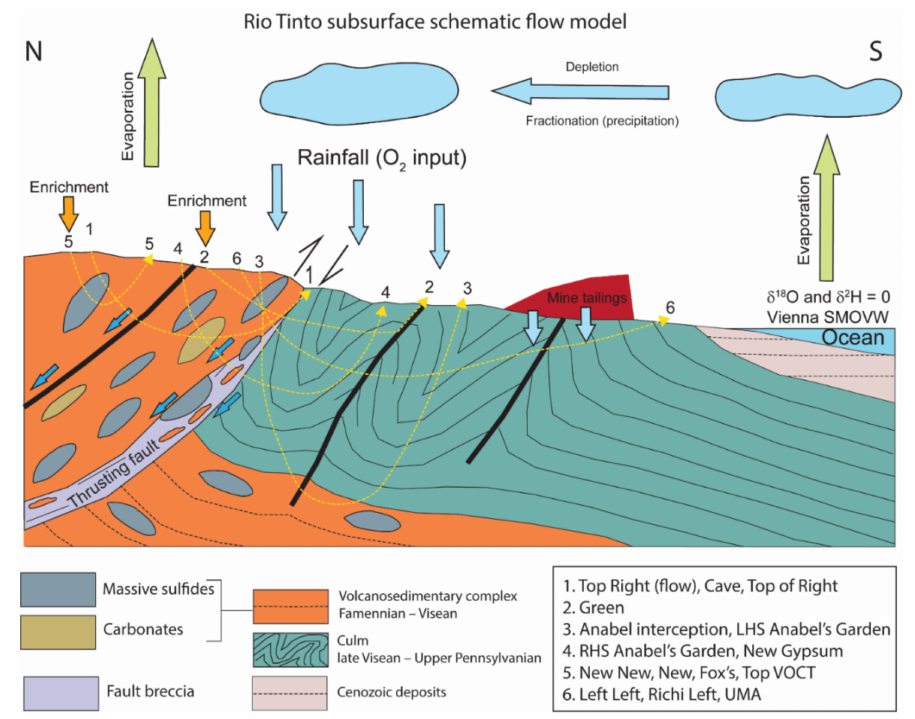
Figure 19. A model for the subsurface flows supplying the various spring around Peña de Hierro in the Rio Tinto